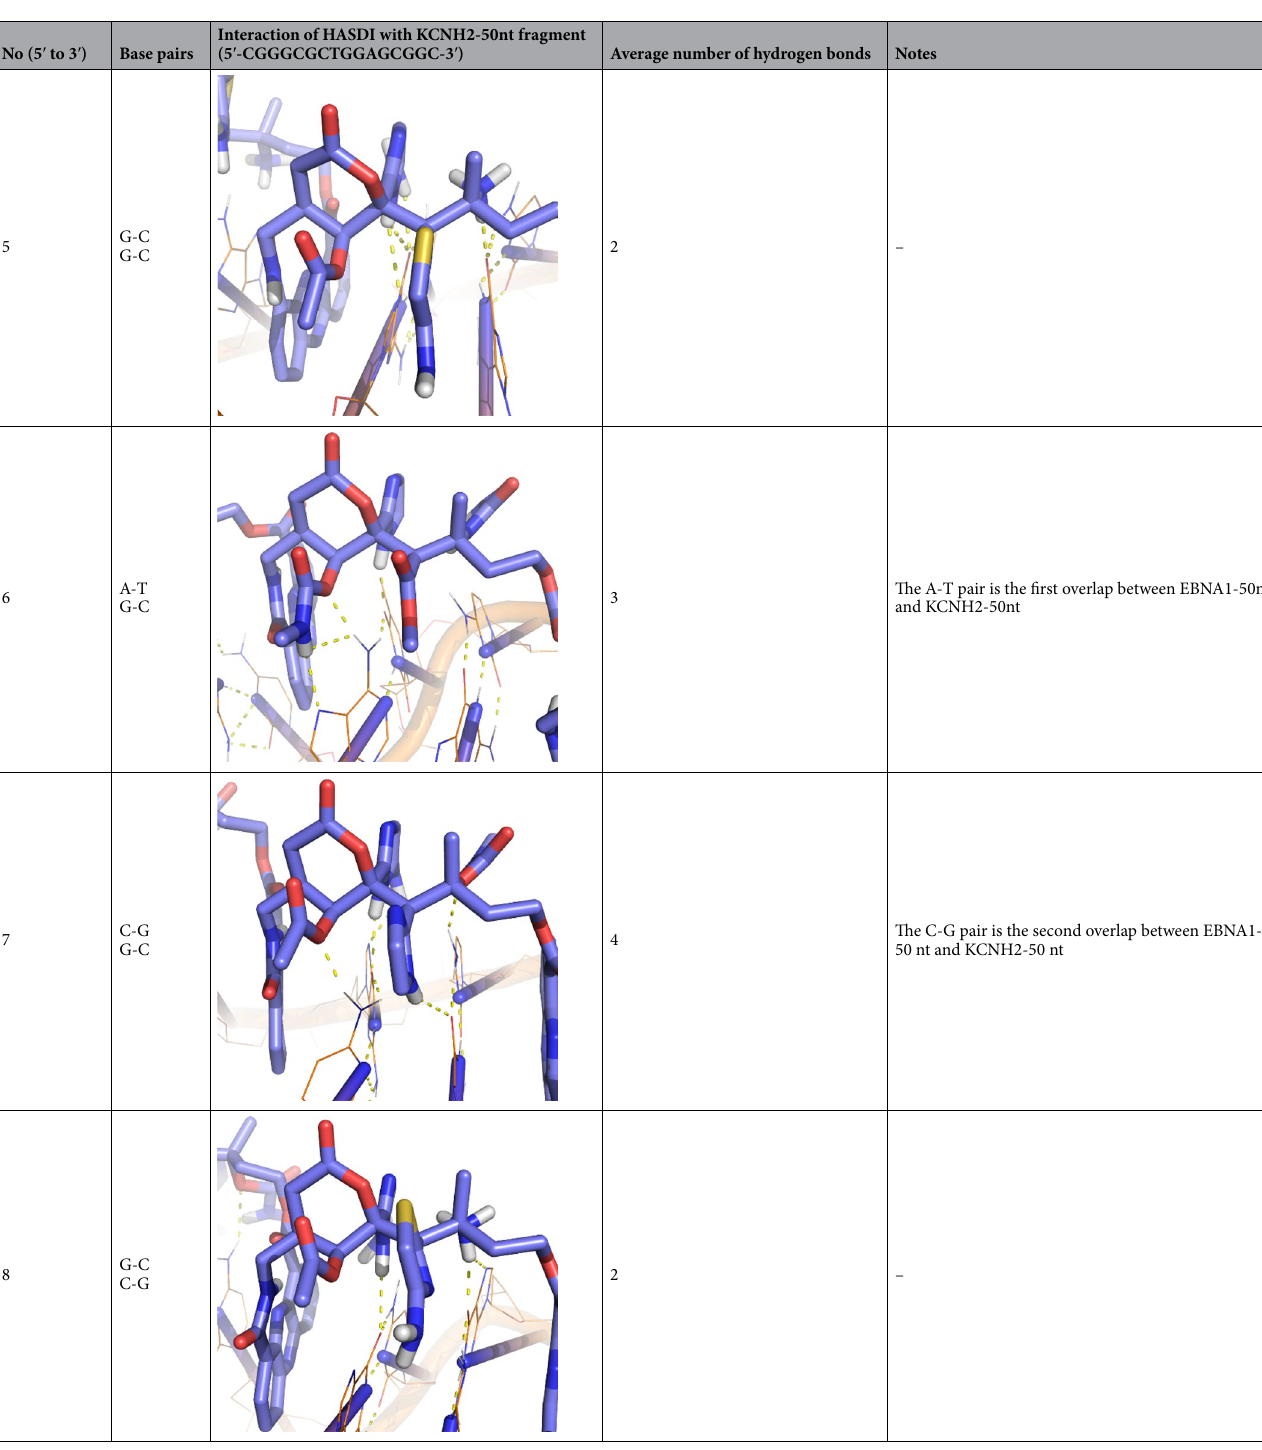
Table 3. Features of the interaction of HASDI with the sequence 5 ′ -CGG GCG CTG GAG CGGC-3 ′